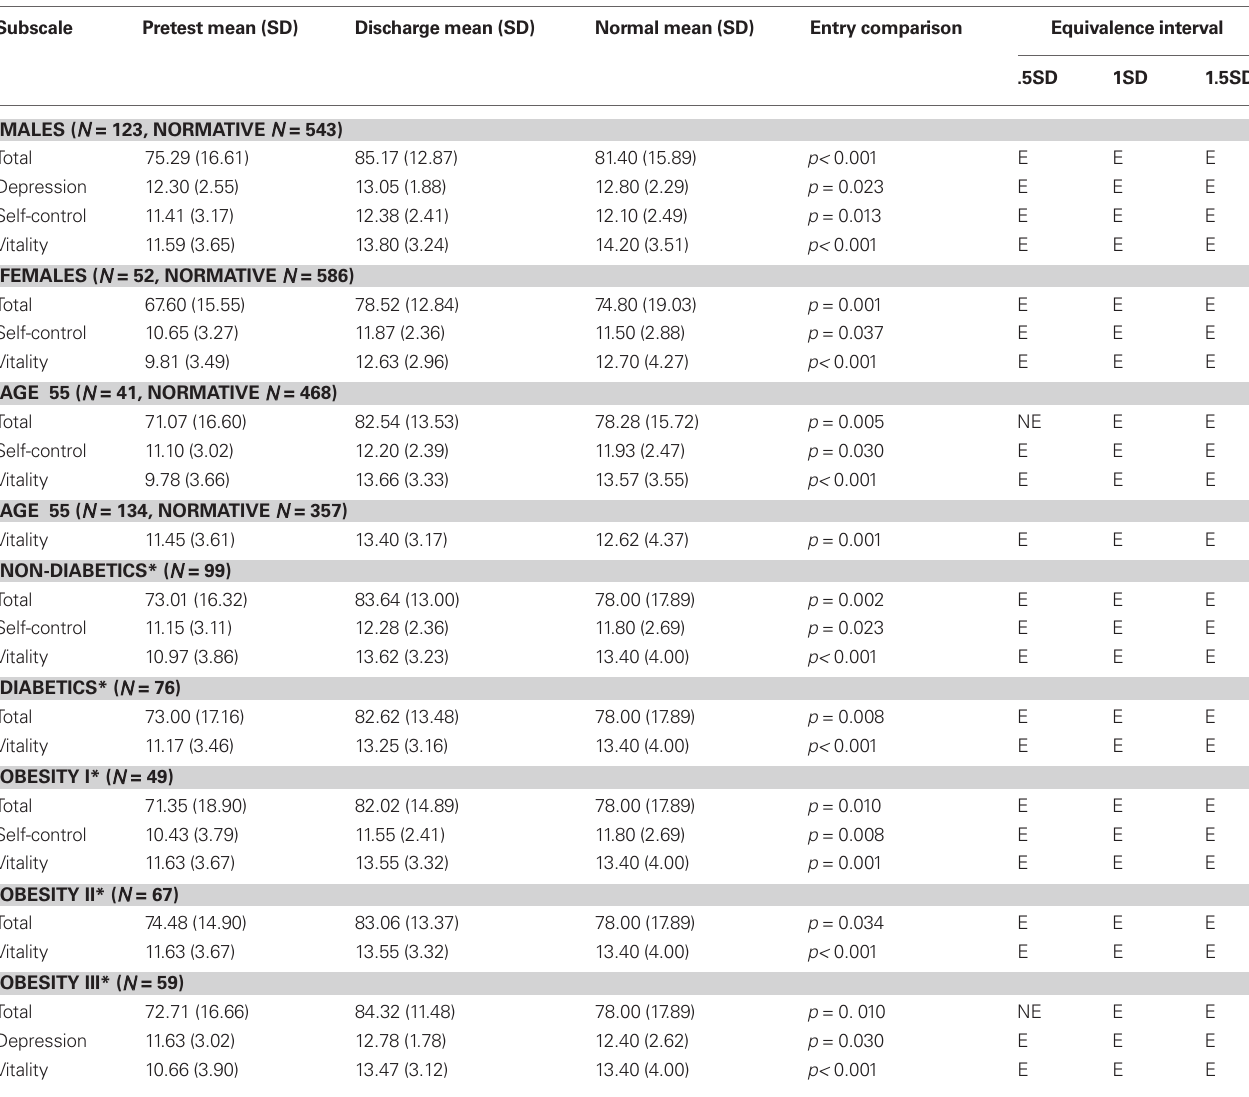
Table 3 | Normative comparisons for subgroups of the patient data for the subscales of the PGWBI. Subscale Pretest mean (SD) Discharge mean (SD) Normal mean